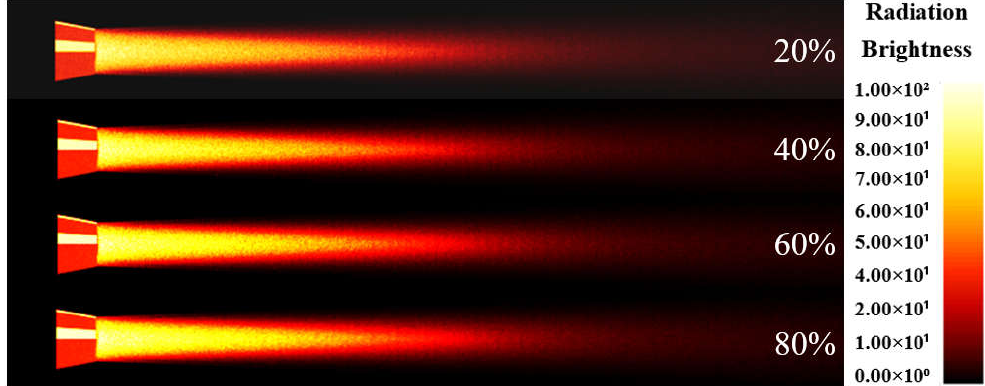
Figure 15. Imaging comparison of different damage degrees at 90°.